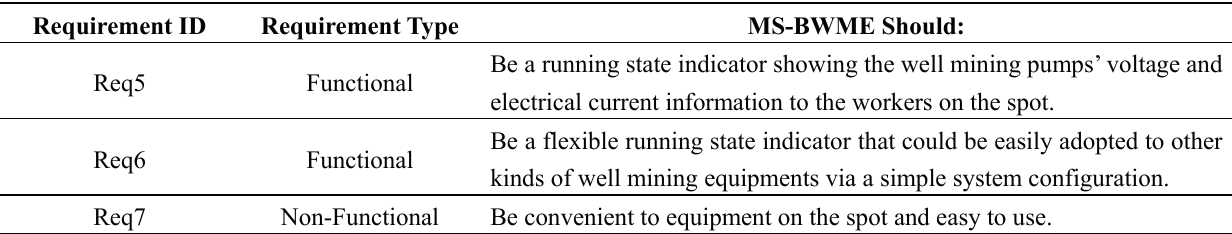
Table 3. Well mining workers’ requirements for